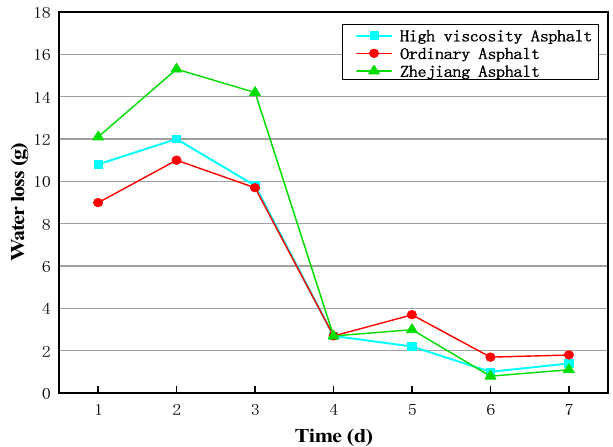
Figure 7. Water loss of samples prepared by different emulsifying leaching.